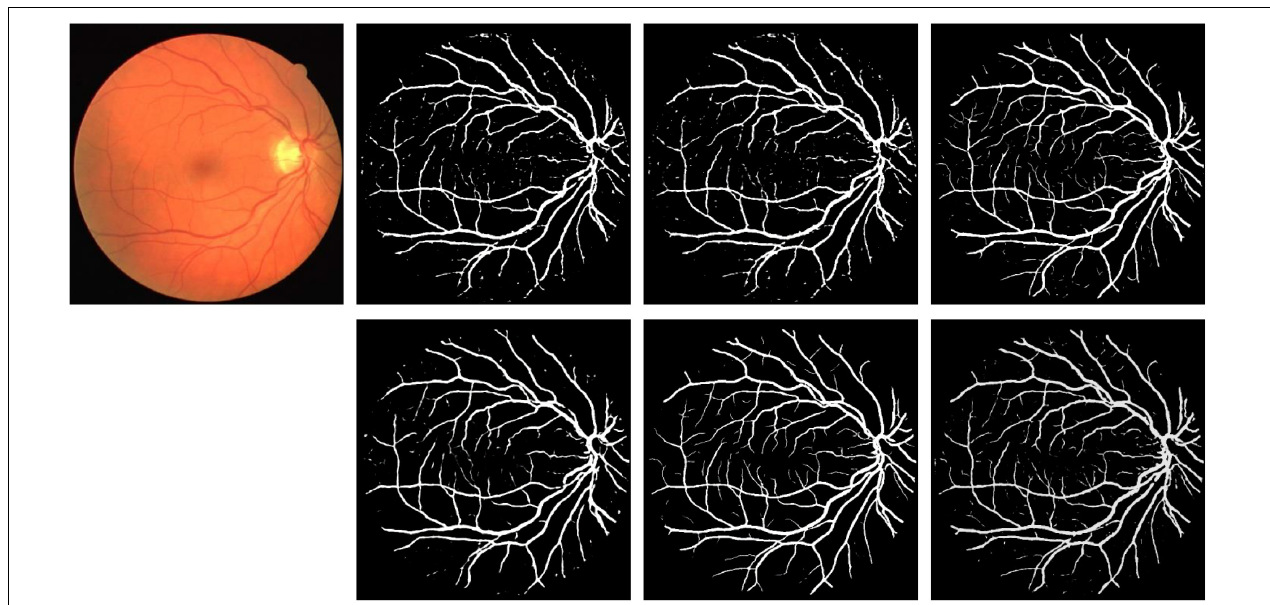
FIGURE 12 | Segmentation results for DRIVE dataset. Row 1, column 2: UNet; row 1, column 3: UNet + + (L4); row 1, column 4: dilated UNet(L2); row 2, column 2: DHP-horizontal EUNet; row 2, column 3: U ∗ Unet; row 1, column 4: U ∗ U ∗ UNet.